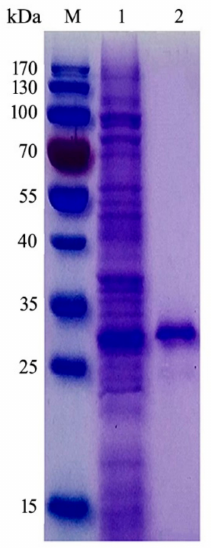
Figure 3. Dodecyl sulfate-polyacrylamide gel electrophoresis (SDS-PAGE) analysis of purified CsnB. M, molecular marker; 1, crude enzymes; 2, purified CsnB. The molecular weight of purified CsnB (theoretical molecular: 30.89 kDa) after Ni-NTA sepharose column was measured to be about 30 kDa by